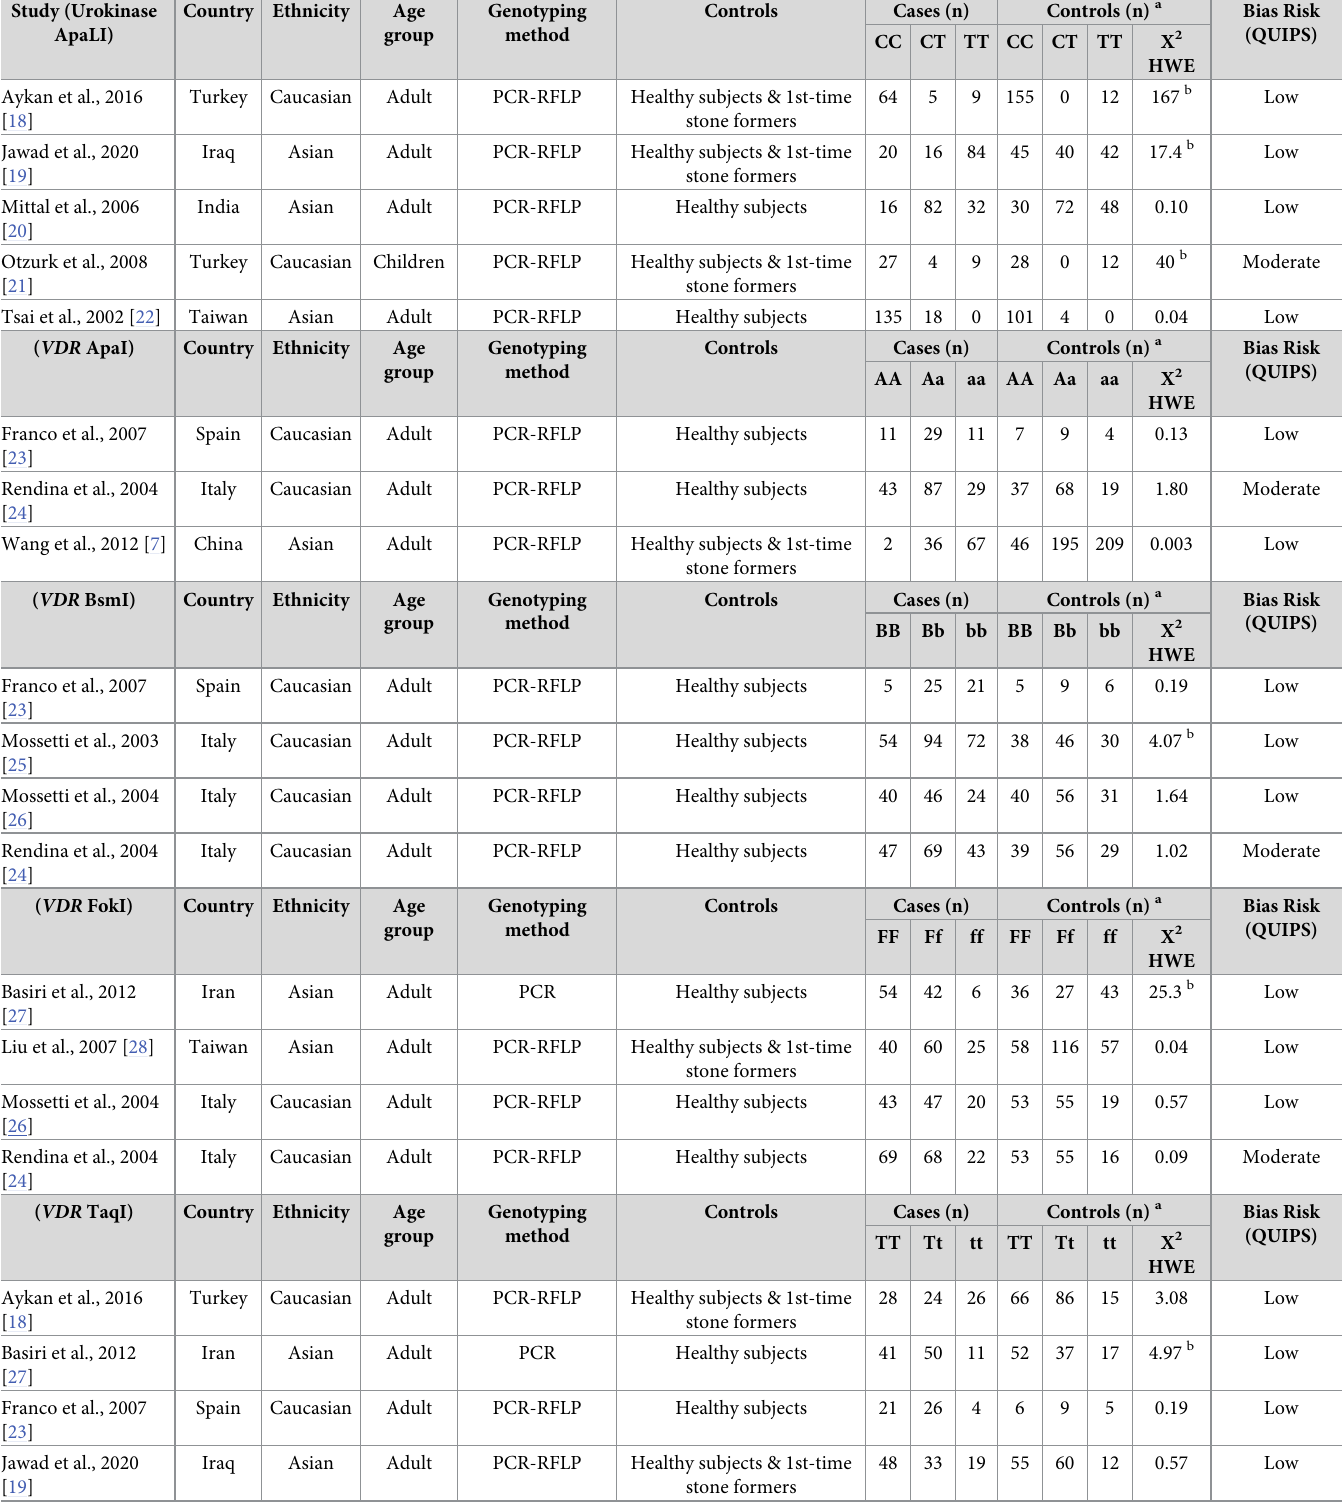
Table 2. Characteristics of individual studies included in the